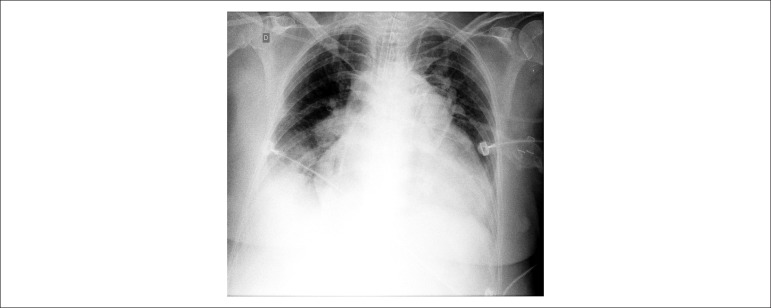
Chest X-ray. More penetrated than the previous one. Presence of endotracheal
cannula. Pulmonary congestion, opacification at the right base and
cardiomegaly with double contour (enlargement of the left atrium) and
abnormal enlargement or bulging at mid-arch of the aorta (right ventricle
enlargement).